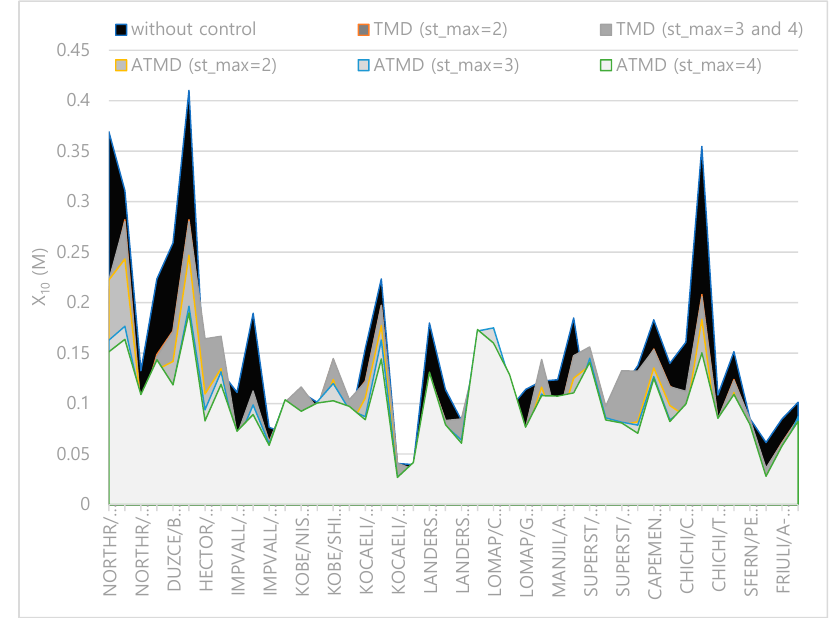
Figure 6. Maximum top story displacement plot for FEMA P-695 far-field ground motions.